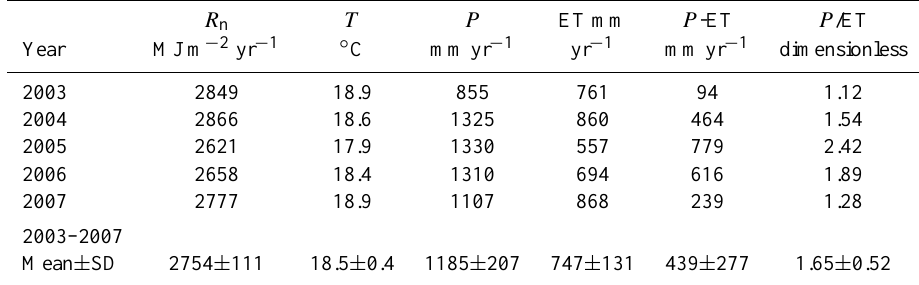
Table 1. Interannual variability in annual net radiation ( R n ), air temperature ( T ), total precipitation ( P ), evapotranspiration (ET) and water balance ( P -ET, P /ET) from 2003 to 2007 at Qianyanzhou site. R n T P ET mm P -ET